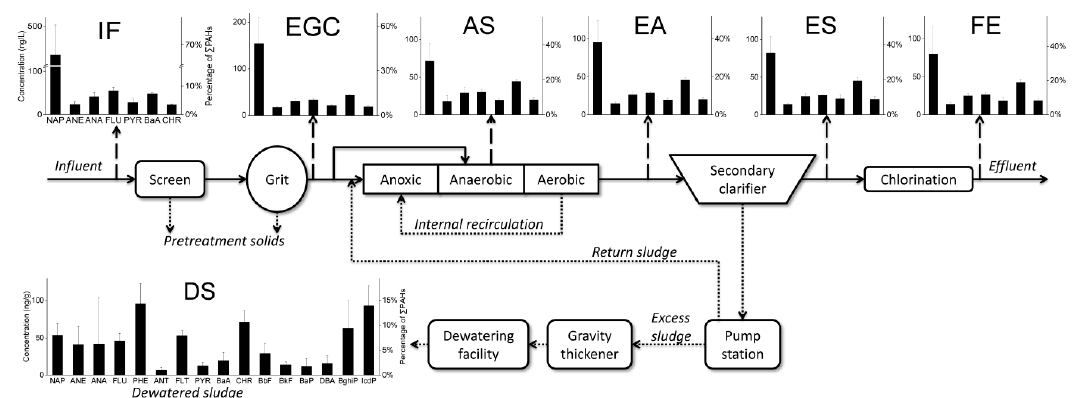
Figure 1. Treatment stages in the WWTP and the sampling points for PAHs. Error bars represent 1 standard deviation of the mean. IN = influent; EG = the effluent of grit chamber; AS = the water-sludge mixture in aerobic stage; EA = the effluent of inverted A 2 /O tank; ES = the effluent of the secondary clarifier; FE = the final effluent after chlorination; DS = dewatered sludge.